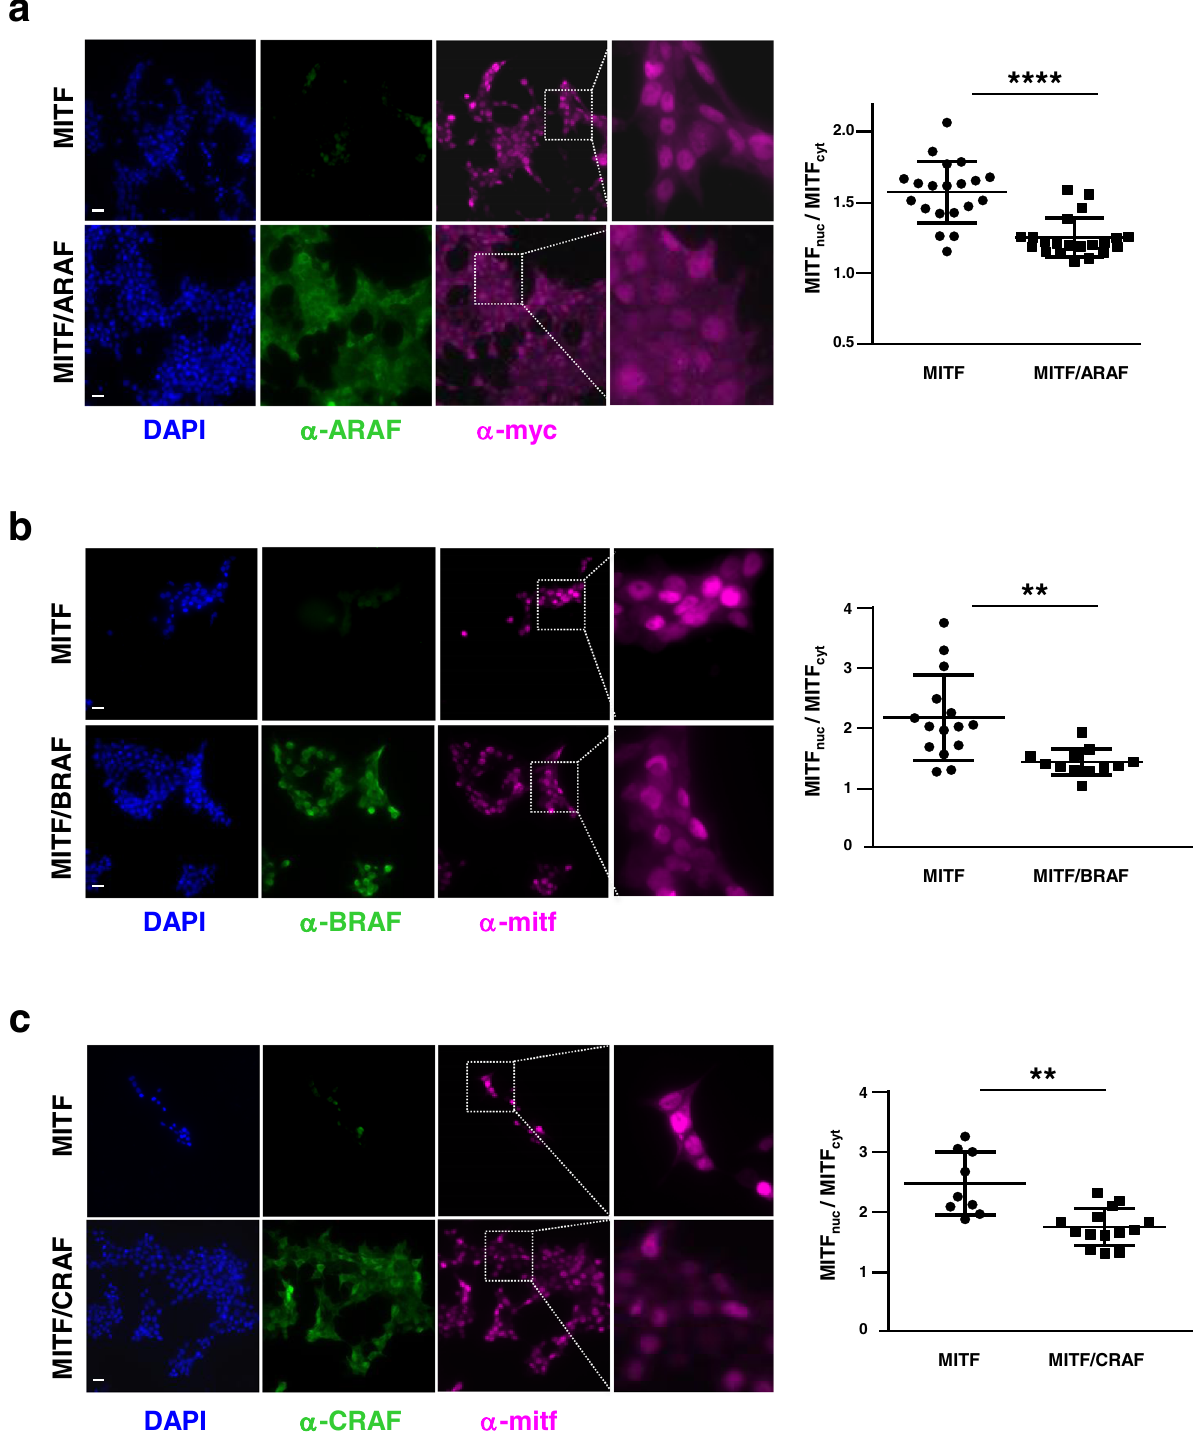
Fig. 5 Effect of RAF proteins on MITF subcellular localization. Subcellular localization of MITF in the presence of ARAF ( a ), BRAF ( b ) or CRAF ( c ). HEK293T cells were cotransfected with myc-MITF and HA-ARAF, HA-BRAF or HA-CRAF. Cell immunostaining was performed with anti-myc or anti-MITF and anti-ARAF, anti-BRAF or anti-CRAF. Scatter plots represent the ratio MITF nuc /MITF cyt calculated by measuring the quantity of nuclear MITF over cytoplasmic MITF. Means with standard deviations are shown. Scale bar: 200 µ m; **** p value < 0.0001, ** p value = 0.014 or 0.029 (for BRAF and CRAF, respectively) compared by unpaired t test with Welch ’ s